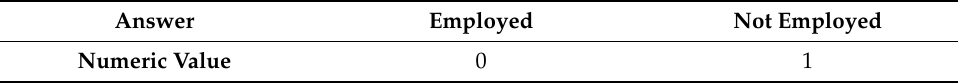
Table 4. Numeric values on whether participants are employed or not (D3).